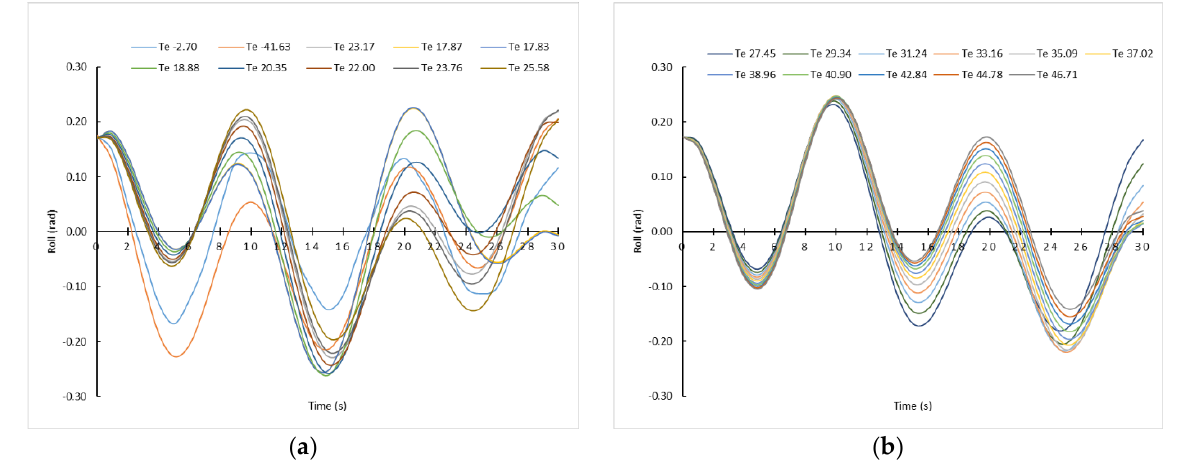
Figure 8. Rolling motion sailing at 8.0 knots and induced by waves with resistance with an α angle of 120°. Td = 9 s. θ MAX = 10°. ( a ) Te from Te −2 .70 s to 25.58 s. ( b ) Te from Te 27.45 s to 46.71 s.